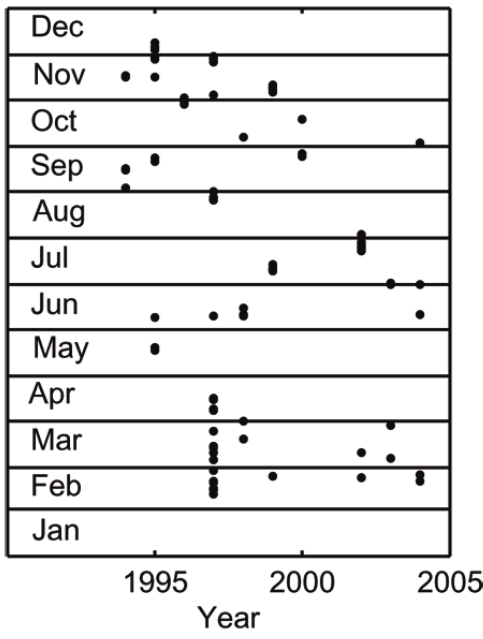
Table 1. Heater configurations used during the selected